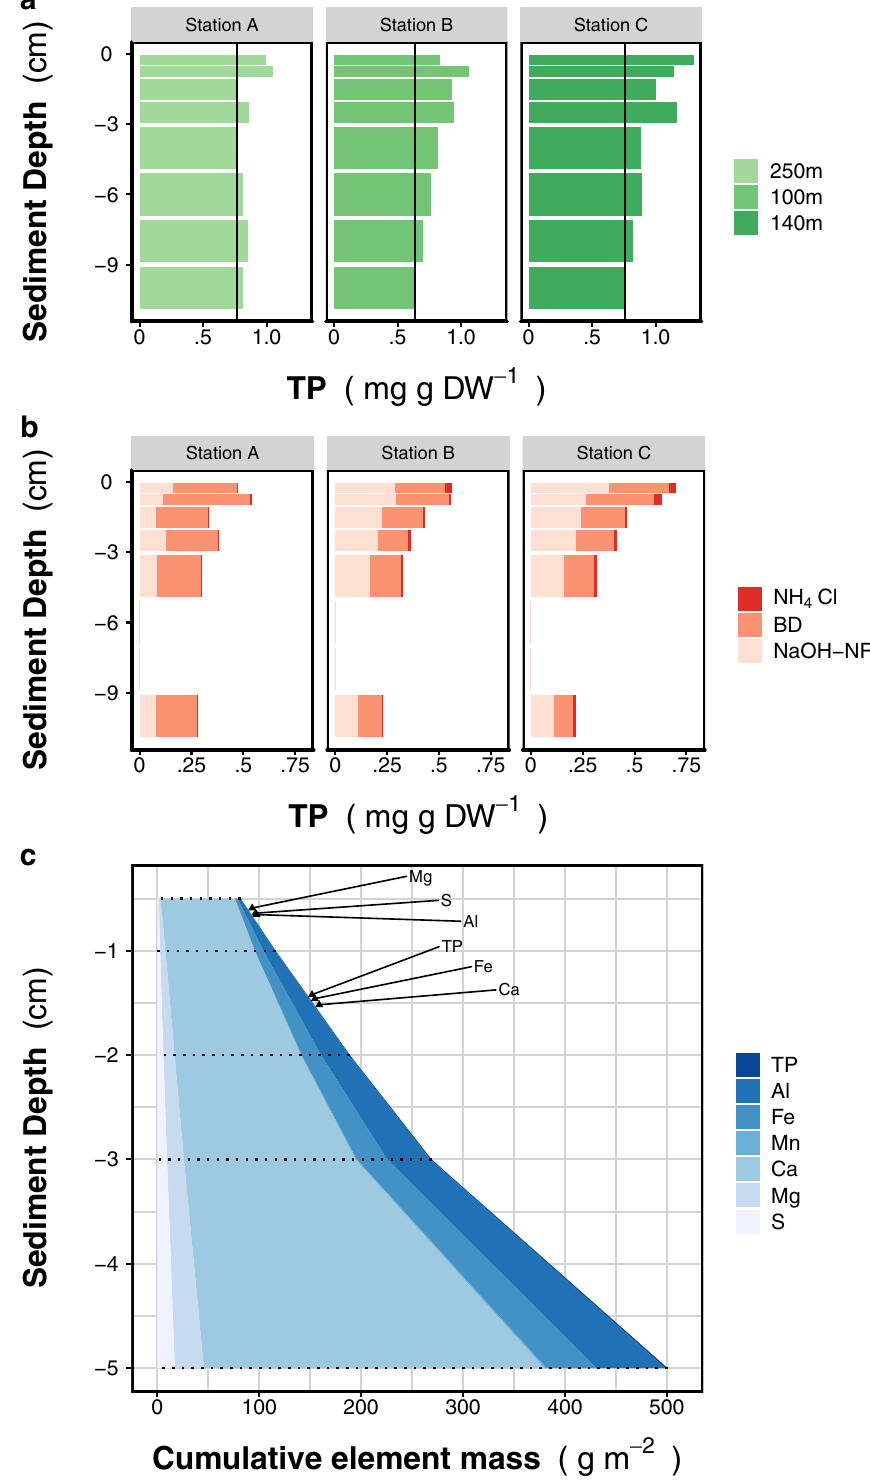
Figure 4. Sediment characteristics of Lake Iseo. ( a ) Total phosphorus (TP) concentration (mg per grams of dry weight) in sediment layers below the sediment–water interface. The black vertical lines indicate a background concentration and exceeding TP is considered to be “mobile P”. Values for sediments between 5 and 9 cm at station B are missing and were interpolated from values above and below. ( b ) Mobile TP fractions differentiated according to a sequential fractionation in redox-sensitive P (BD), free and loosely adsorbed P (NH 4 Cl), organic P and poly-P (NaOH-NRP) 74 . Note scale differences between the panels ( a ) and ( b ). ( c ) Content of selected sediment constituents in surface sediment (Station B). Labeled arrows indicate the specific equilibrium depth up to where the cumulated dry mass contains the same amount of an element as did the settling material collected over one year by the shallow trap. For Mn this value is out of range. Cumulative mass profiles, and additional data can be found in the Supplementary Figure S1 and Table